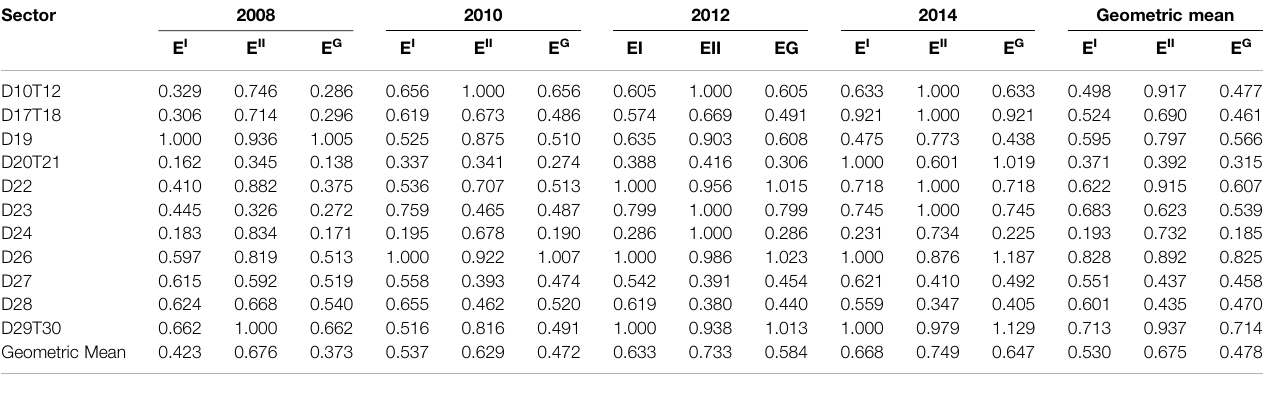
TABLE 2 | Two-stage ef fi ciency and overall GIVC ef fi ciency.